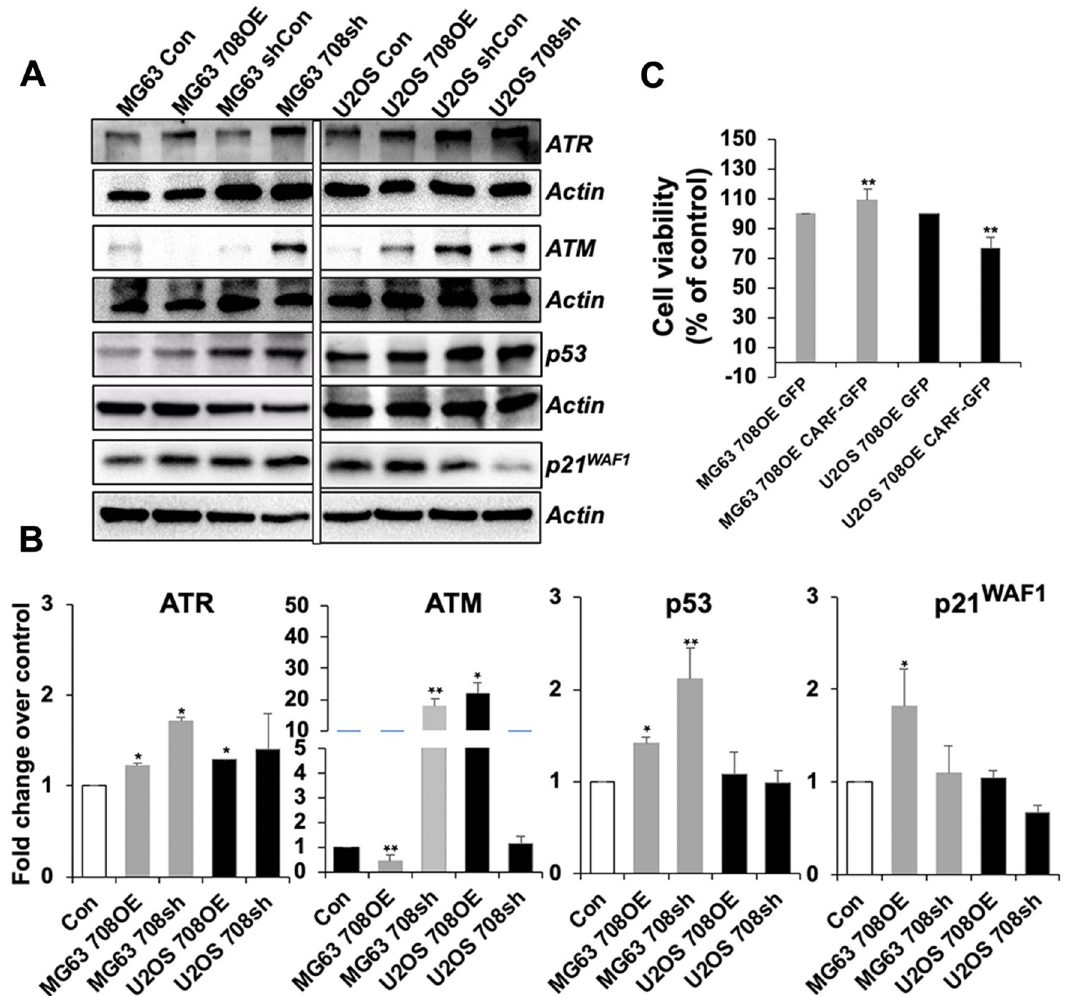
Figure 7. miR-708 differentially regulates CARF-ATM-p53-p21 signaling in TEP and ALT cells. ( A ) ATR, ATM, p53 and p21 WAF1 protein levels. Whereas ATR did not show differential expression in miR-708- overexpressing and compromised cells, ATM expression was reduced and elevated by miR-708 overexpression and knock-down, respectively, only in TEP cells. ALT cells showed the opposite effect. Further, p53 was upregulated in TEP cells while it was unchanged in ALT cells. p21 WAF1 was increased in miR-708-overexpressing TEP cells only and showed no change in ALT cells. ( B ) Quantitation of the data (mean ± SD) obtained from at least 4 independent Western blots. ( C ) CARF restoration in miR-708 overexpressing TEP and ALT cells. Whereas TEP cells showed an increase in cell growth in CARF restored miR-708 overexpressing cells, ALT cells showed a decrease. * p < 0.05; ** p < 0.01